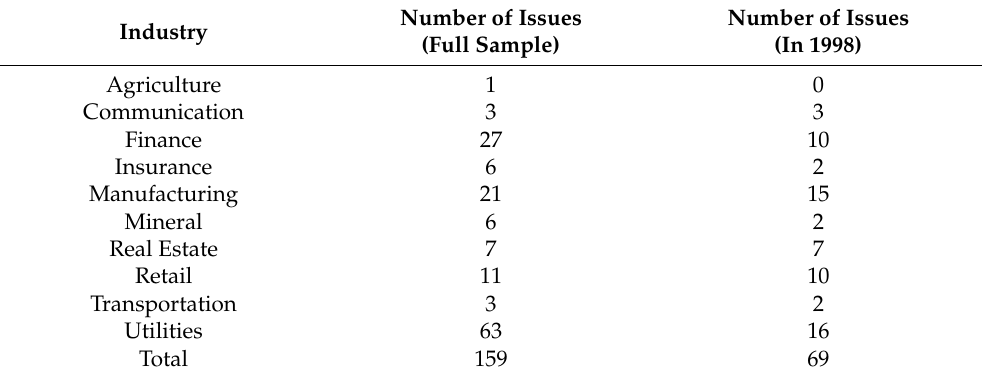
Table 1. Industry classification of issuing firms.